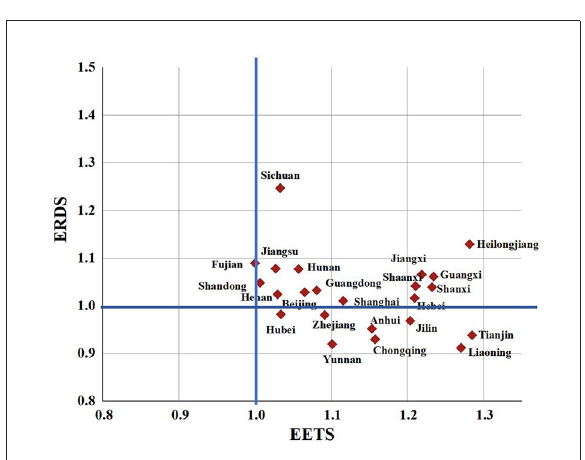
FIGURE9 Clustering analysis chart of ERDS and EETS in provincial pharmaceutical manufacturing